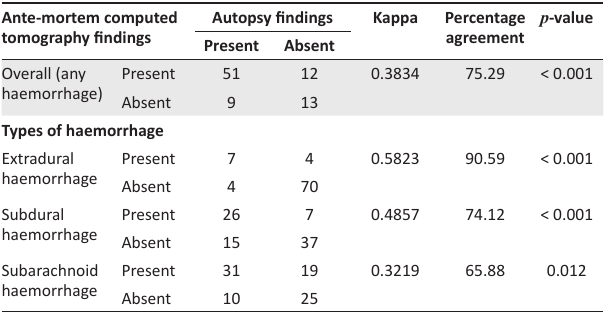
TABLE 1: Agreement between autopsy and ante-mortem computed tomography findings in the detection of intracranial haemorrhages, South Africa, 2014–2016.